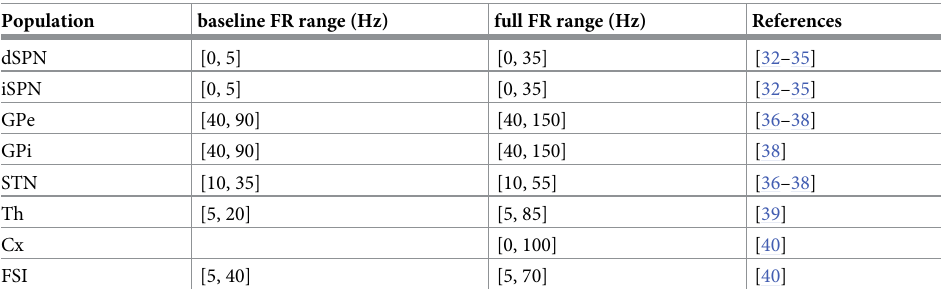
Table 2. Firing rate ranges during baseline and during decision tasks for different populations in the brain. These ranges reflect experimental data from both primates and